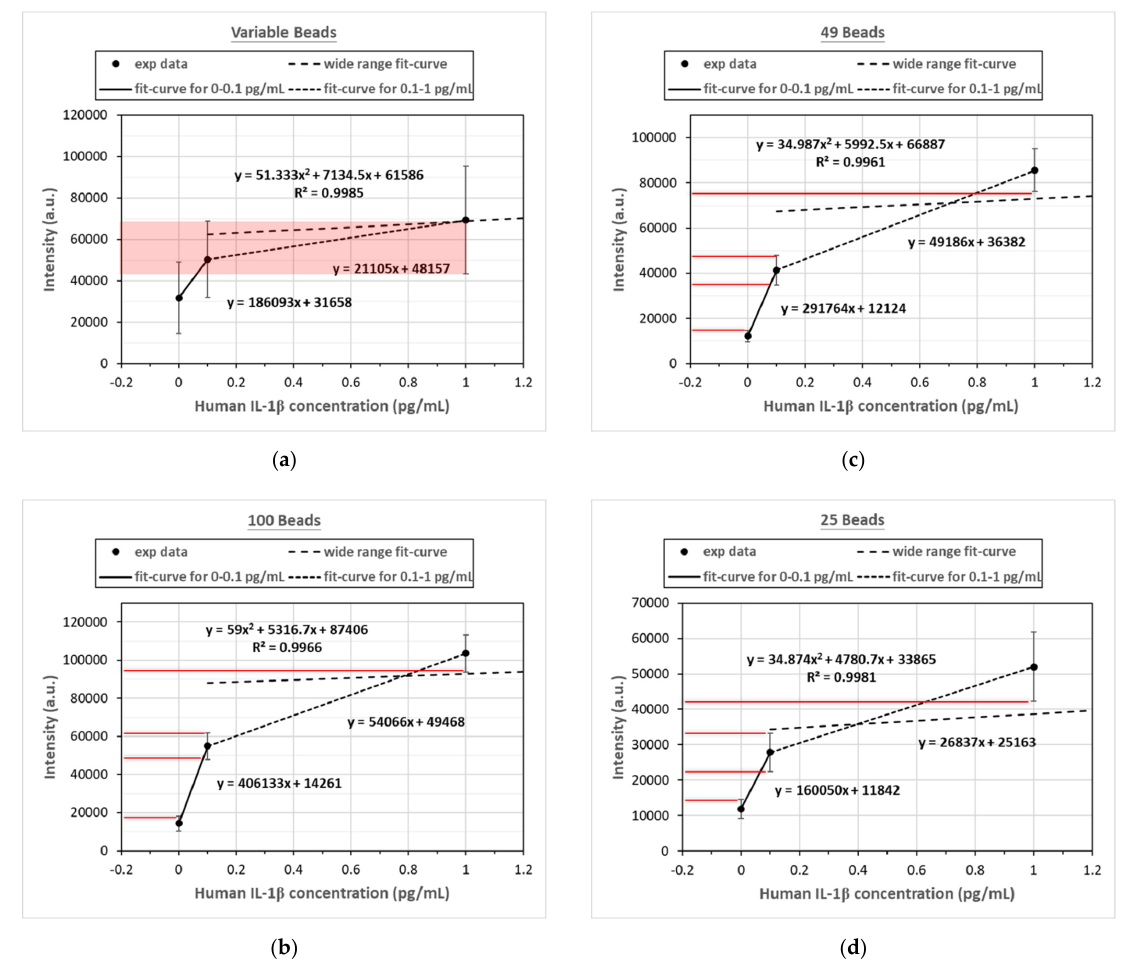
Figure 6. Fluorescence intensity distribution and composite calibration curves for the unfixed number of magnetic beads and for the other three with fixed numbers of magnetic beads at the low concentrations of 0.0 pg/mL, 0.1 pg/mL, and 1.0 pg/mL. ( a ) The measured fluorescence intensity distribution overlaps when the number of magnetic beads is unfixed (50–160). When the fixed num- bers of magnetic beads are ( b ) 100 beads, ( c ) 49 beads, or ( d ) 25 beads at concentrations of 0.0 pg/mL, 0.1 pg/mL, and 1.0 pg/mL, respectively, the fluorescence intensity distributions do not overlap. The LODs for ( a ) variable beads, ( b ) 100 beads, ( c ) 49 beads, and ( d ) 25 beads are 3.0 pg/mL, 0.0287 pg/mL, 0.0255 pg/mL, and 0.0508 pg/mL, respectively. n = 3. Using the composite calibration curves, the calculated LODs for variable beads, 100 beads, 49 beads, and 25 beads were 3.0 pg/mL, 0.0287 pg/mL, 0.0255 pg/mL, and 0.0508 pg/mL, respectively. The method to calculate the LOD value was the typical blank deter- mination method, in which the concentration was calculated by the calibration curve with the fluorescent intensity of the mean value plus three standard deviations at blank. The LOD was reduced by about three orders from 3.0 pg/mL (for varying numbers of beads) to 0.0287 pg/mL (for 100 beads).